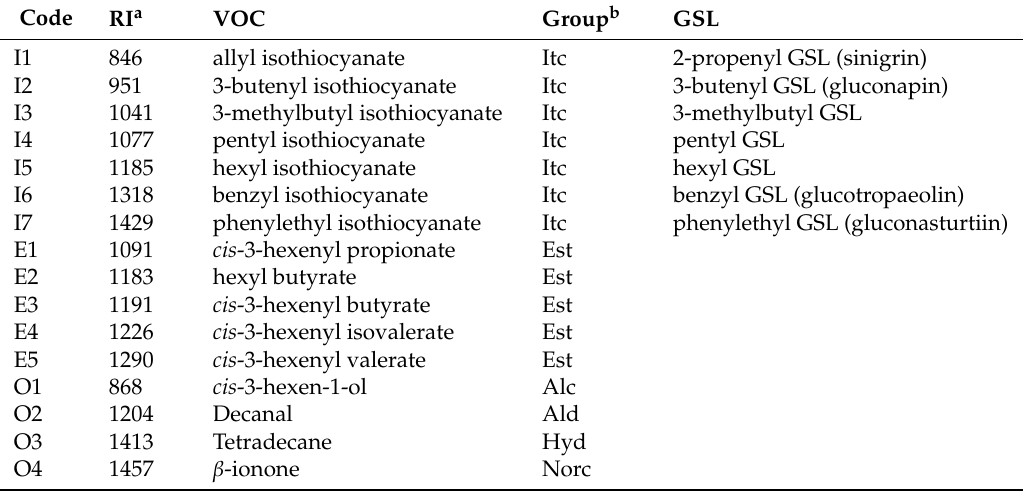
Table 3. List of volatile organic compounds (VOCs) identified in the present study including their chemical group and code assigned. The corresponding glucosinolate (GSL) from which each isothiocyanate derives is also